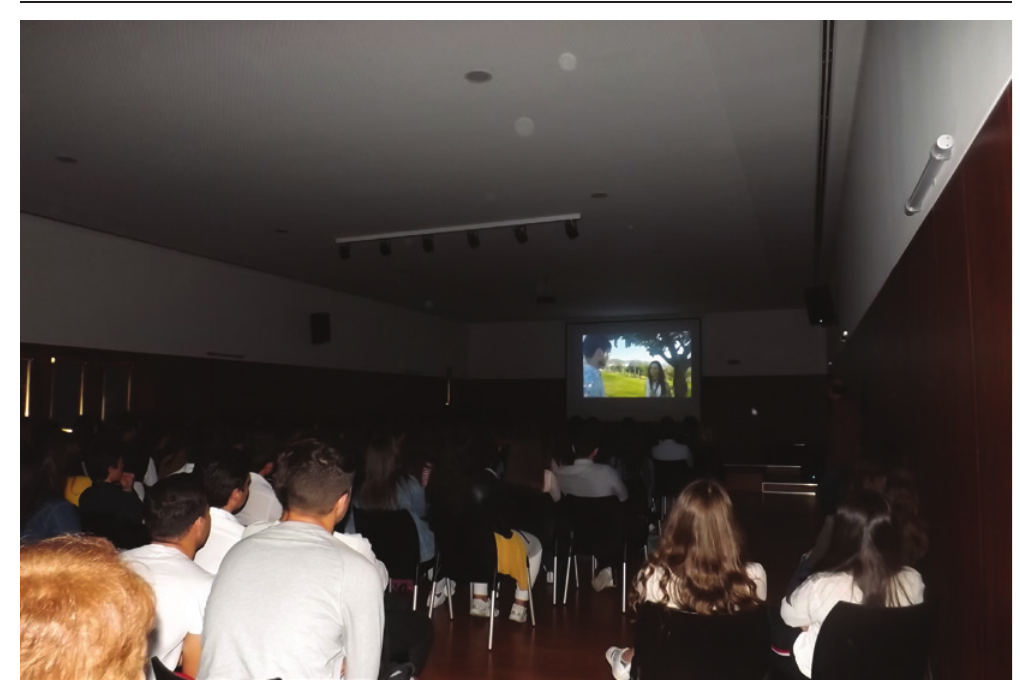
figure 5: Students’ final